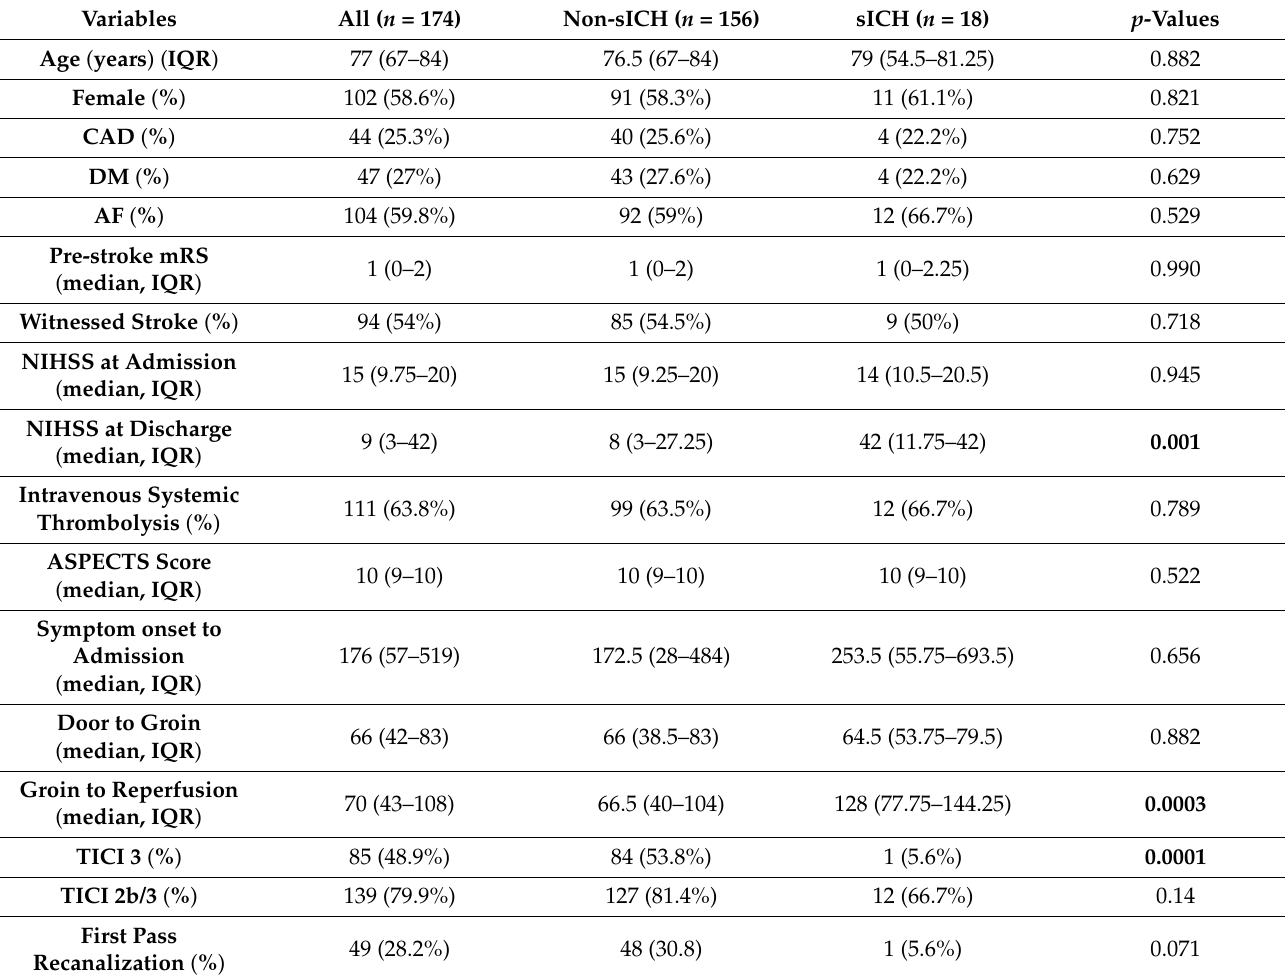
Table 1. Baseline characteristics, endovascular and neurological outcomes of